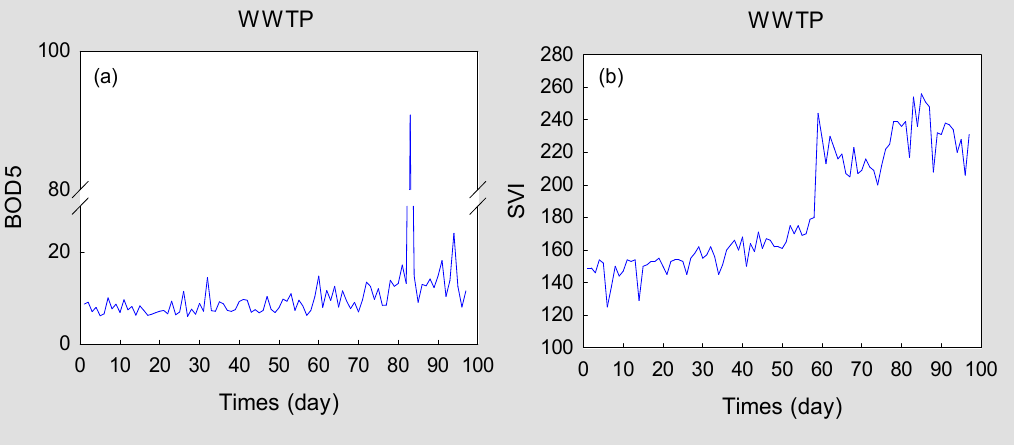
Figure 6. Isolated variables change curves of sludge bulking: ( a ) Five-day biochemical oxygen demand (BOD 5 ); ( b ) the sludge volume index (SVI).